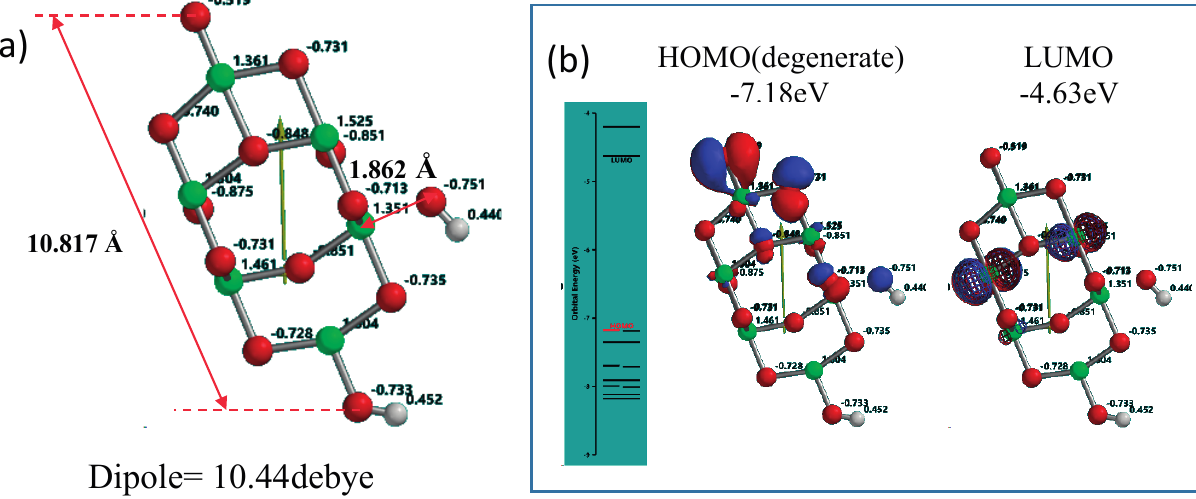
Figure 1. Yamashita/Jono model of OH(TiO 2 ) 9 H as a model of PEC-nc-TiO 2 electrodes, ( a ) Size, distance and Mulliken charge; ( b ) the energy structure and configuration of HOMO and